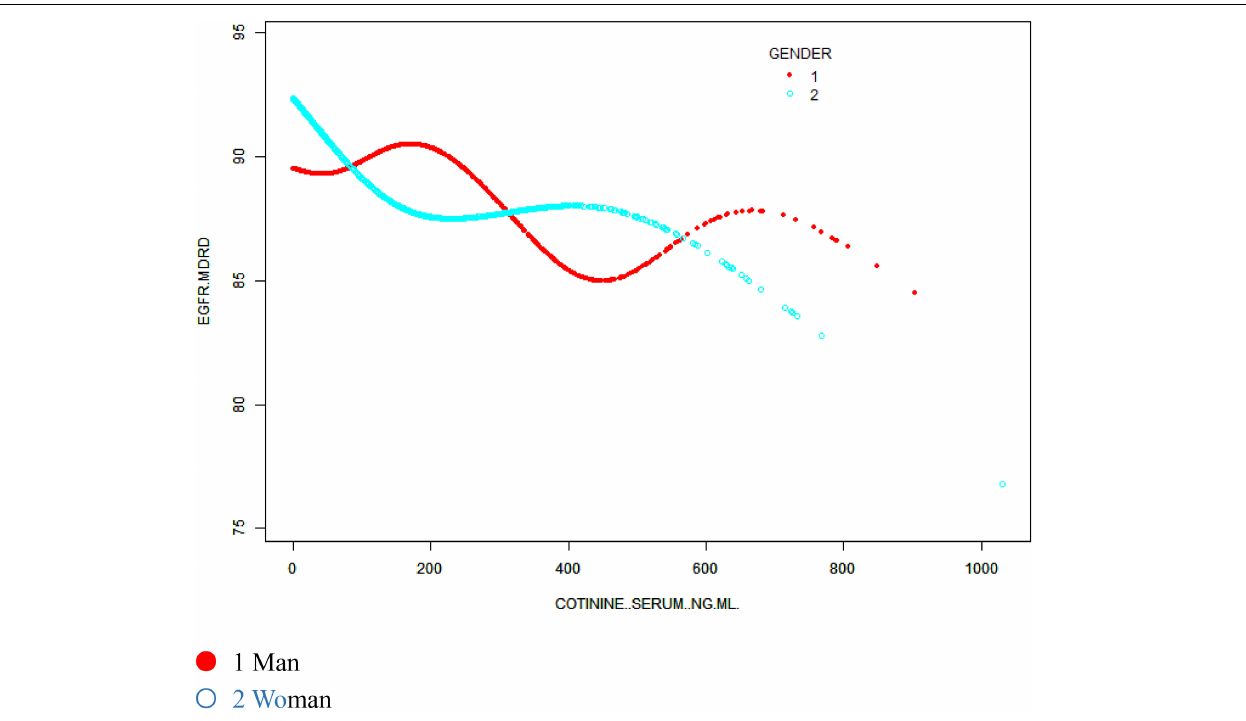
Frontiers in Medicine |